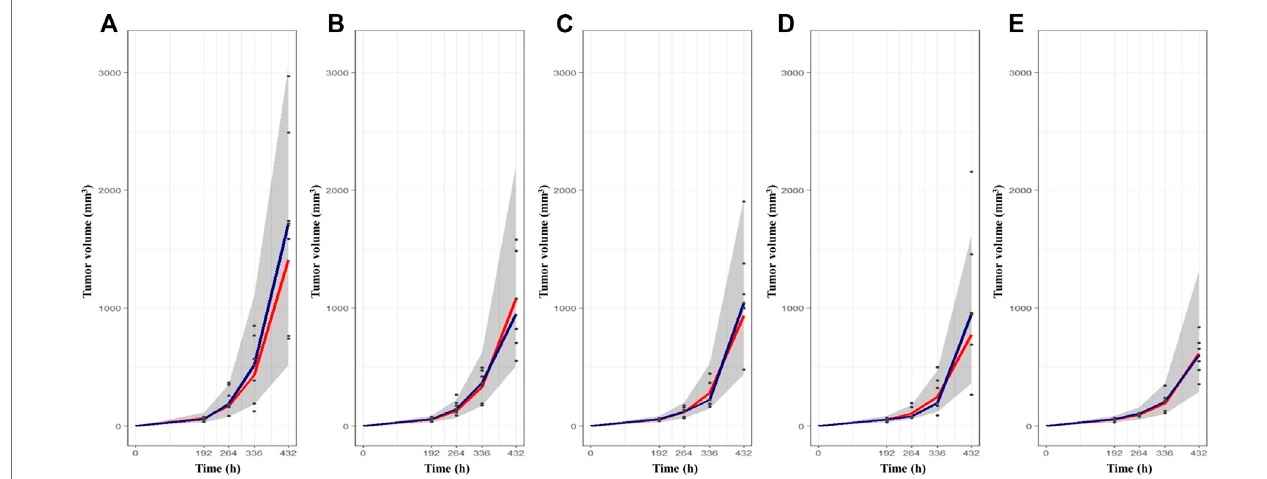
FIGURE 2 | The tumor growth-time pro fi les after BoNT/A1 injection and visual check prediction (VPC) results for fi nal K-PD model. (A) Vehicle control group. (B) BoNT/A1 1.5 U kg − 1 treated group. (C) BoNT/A1 5 U BoNT/A1 1.5 U kg − 1 treated group. (D) BoNT/A1 15 U kg − 1 treated group (E) BoNT/A1 50 U kg − 1 treated group. Black dot, observed tumor volume; Gray shade, 90% simulation intervals; Blue line, observed median value; Red line, simulated median value.